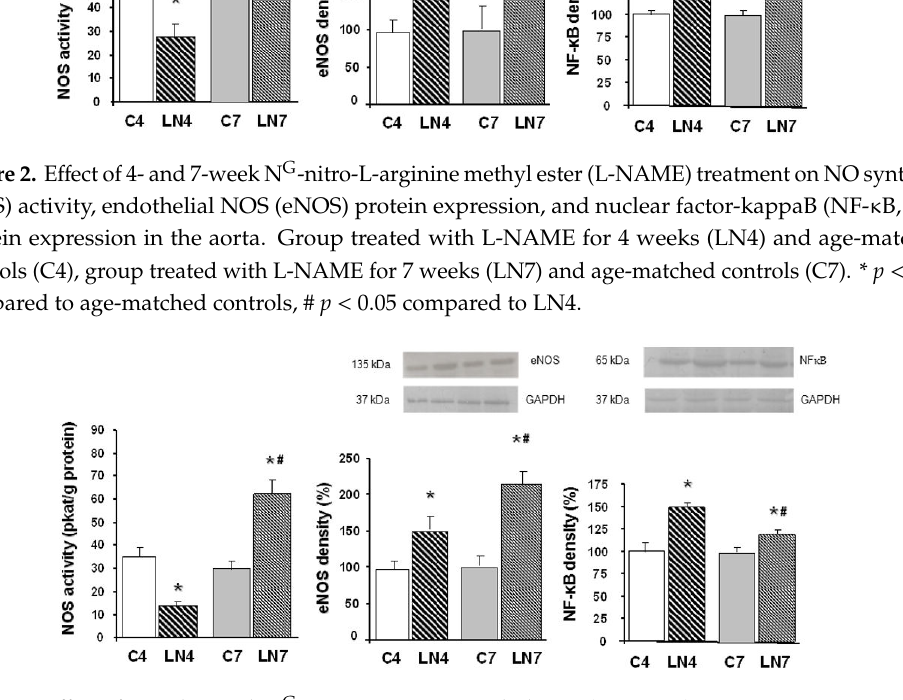
Figure 3. E ff ect of 4- and 7-week N G -nitro-L-arginine methyl ester (L-NAME) treatment on NO synthase (NOS) activity, endothelial NOS (eNOS) protein expression, and nuclear factor-kappaB (NF- κ B, p65) protein expression in the heart. Group treated with L-NAME for 4 weeks (LN4) and age-matched controls (C4), group treated with L-NAME for 7 weeks (LN7) and age-matched controls (C7). * p < 0.05 compared to age-matched controls, # p < 0.05 compared to LN4.